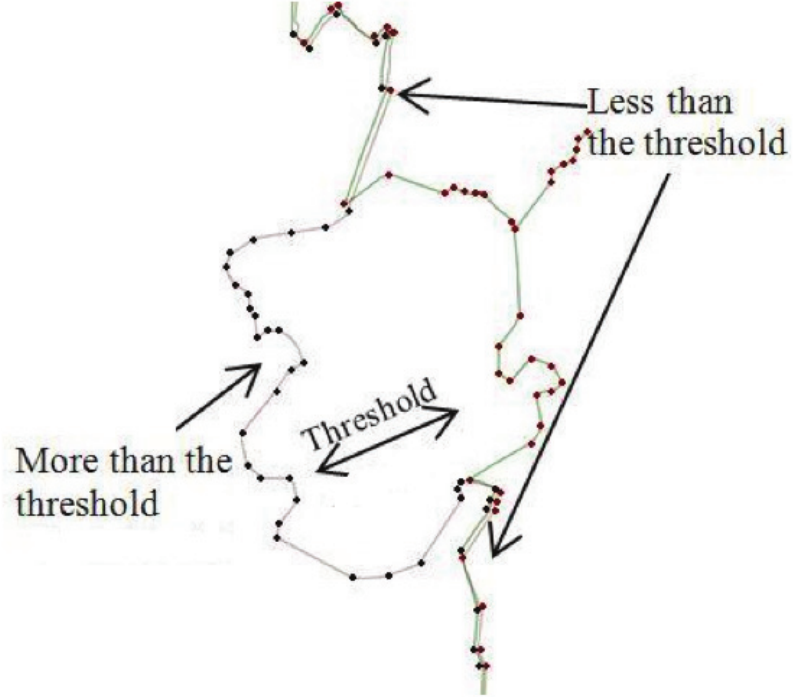
Figure 5: In comparing the thresholds with the node/vertex distances, there are two op- tions: if the distance is less than the defined threshold, then the geometry in the application- specific layer is replaced with the geometry of the base-map; otherwise, the original geom- etry in the application-specific layer is